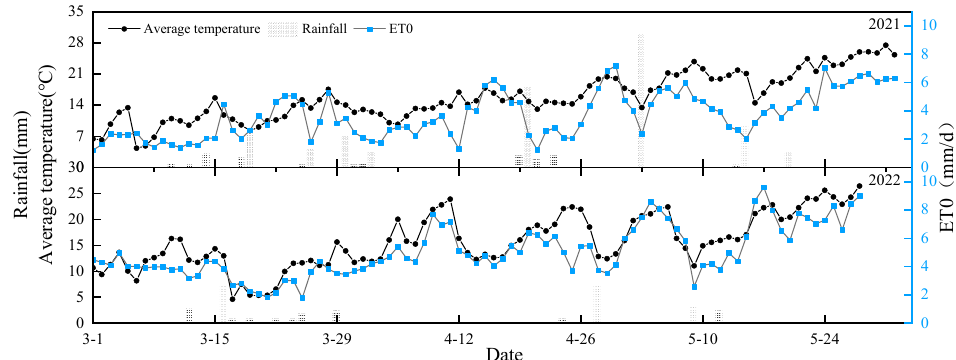
Figure 2. Variations in precipitation, temperature, and reference crop evapotranspiration after winter wheat re-greening.